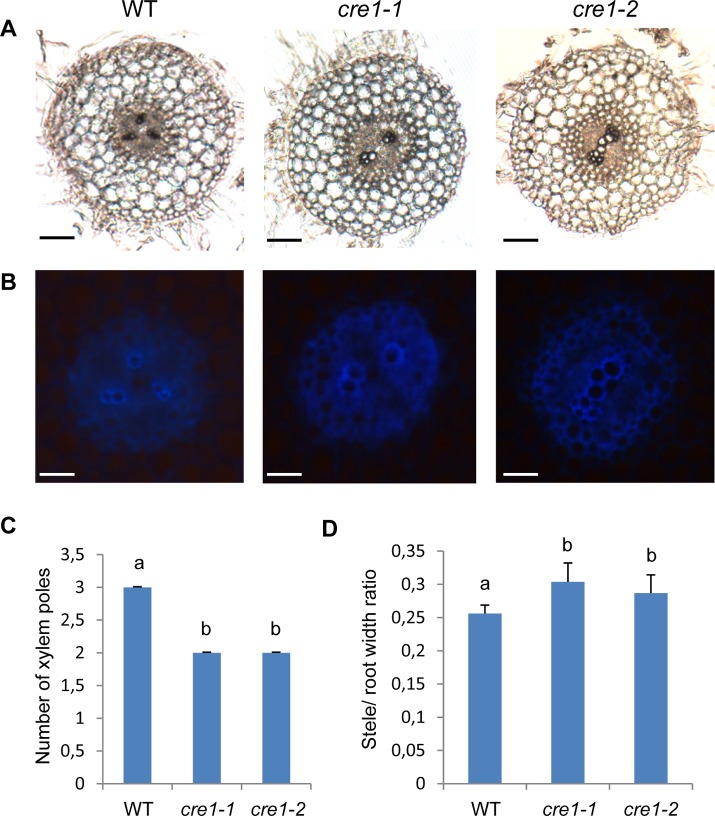

cre1 mutants show defects in vascular bundle differentiation.
A-B. Transversal sections of 7 day-old roots in the Wild-Type (WT) and in the cre1 mutant (cre1-1 and cre1-2 alleles). Sections (80 μm) were made at a 1 cm distance from the root tip. A, bright field images; B, images obtained under UV excitation, revealing the autofluorescence of xylem poles. Bars = 50 μm. C. Number of xylem poles in the Wild-Type (WT) and in the cre1 mutant (cre1-1 and cre1-2 alleles) quantified based on previous sections. D. Stele/root width ratio in the Wild-Type (WT) and in the cre1 mutant (cre1-1 and cre1-2 alleles) quantified based on previous sections. In C and D, error bars represent standard deviation and a Kruskal-Wallis test was used to assess significant differences (letters, α<0.05; n>6).